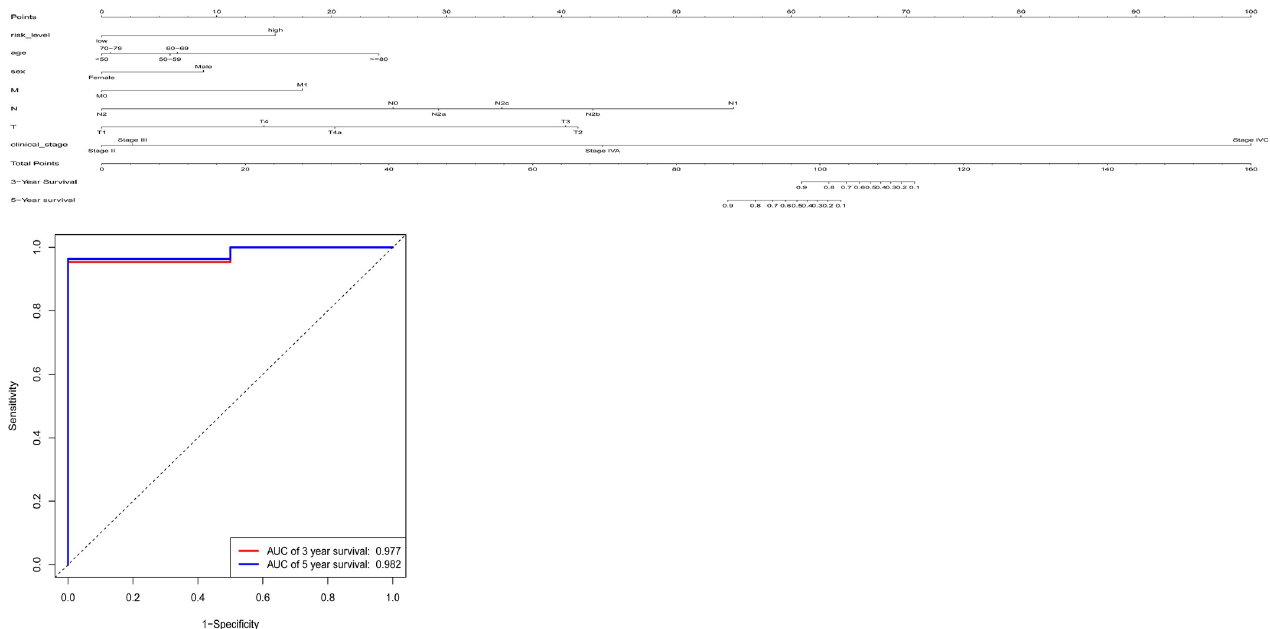
Fig 8. (A) Nomograms to predict 3-y and 5-y survival probability. Total points were calculated by adding up the corresponding points of each individual covariate on the points scale. Then 3-y and 5-y related survival probabilities were obtained by directly converting total points.(B) ROC of both clinical features and 3 key